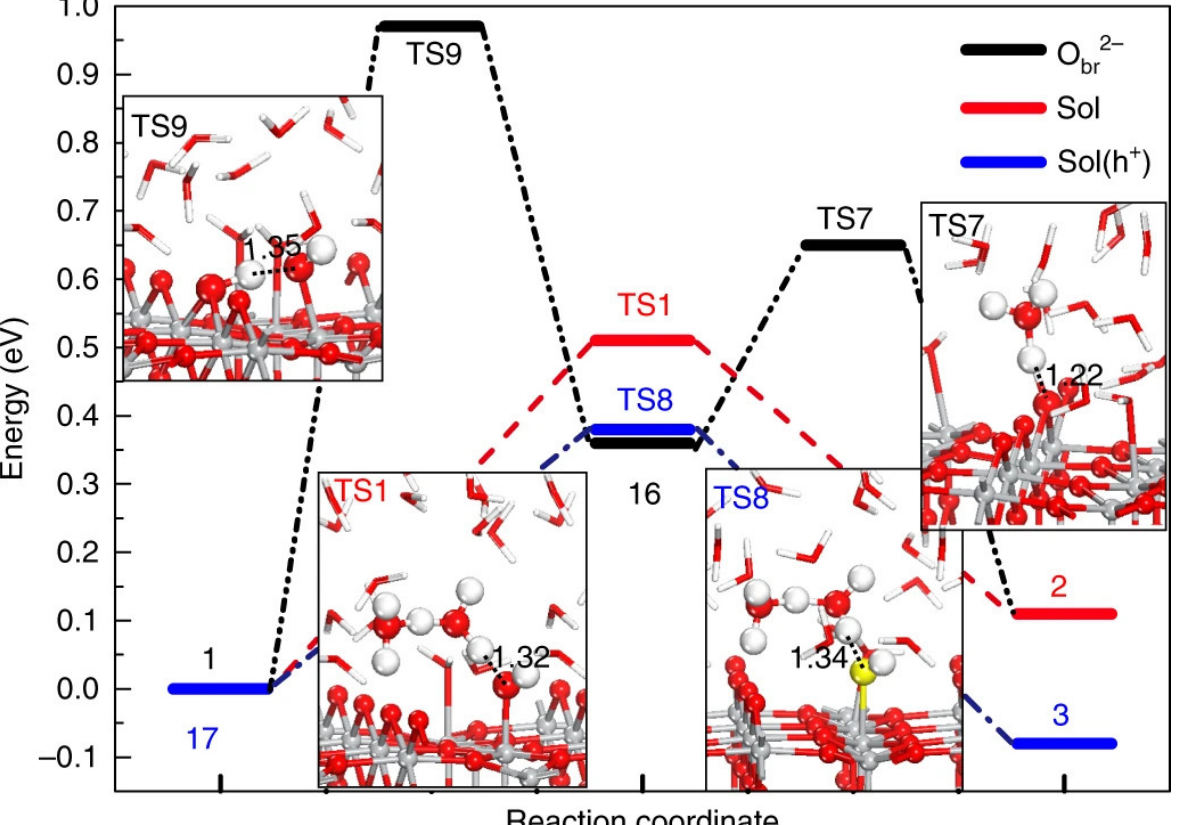
Figure 6. The energy profile diagram of the possible water splitting reaction. At the HSE06 level of theory, three possible pathways are considered: (i) first deprotonation to a nearby O br2− and then into the solution (black), (ii) direct deprotonation into the solution (red), and (iii) with the assistance from the hole for the deprotonation (blue). In the insets the TS structures are shown and the surface radicals are highlighted in yellow (the lengths are in Å unit). (Reprinted from ref. [55] with permission from Nature Catalysis. Copyright © 2018, Nature).